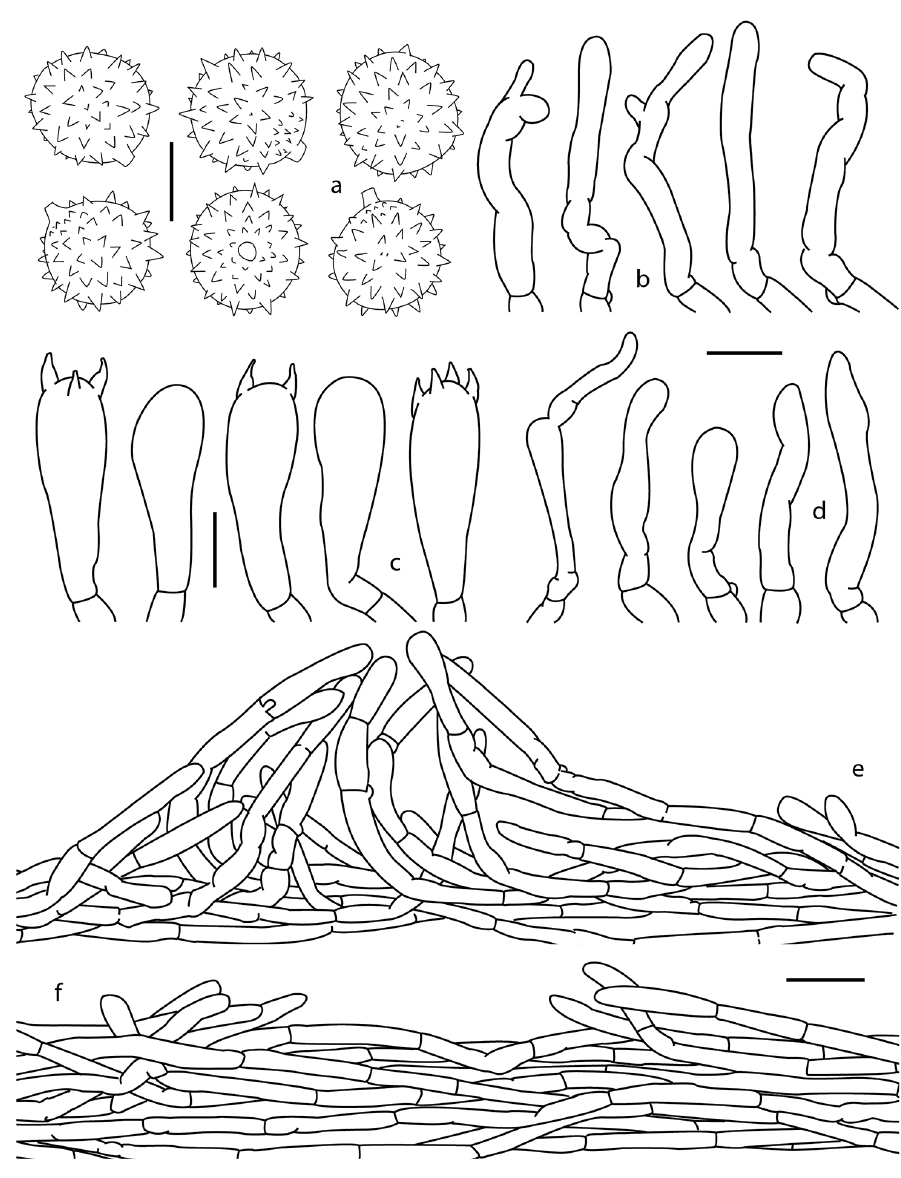
Figure 6. Laccaria trichodermophora, a basidiospores b pleurocystidia c basidia d pileipellis e cheilocys- tidia a–e Montoya 4393. Scale bars: 5 µm ( a ); 10 µm ( b–c, e ); 25 µm ( d ). the third clearly separated, probably representing an undescribed species. A specimen (KP128033) labeled as L. trichodermophora in the GenBank, clustered in L. alba group from Asia in our analysis. This sample lacks geographic information and could well be a misidentified